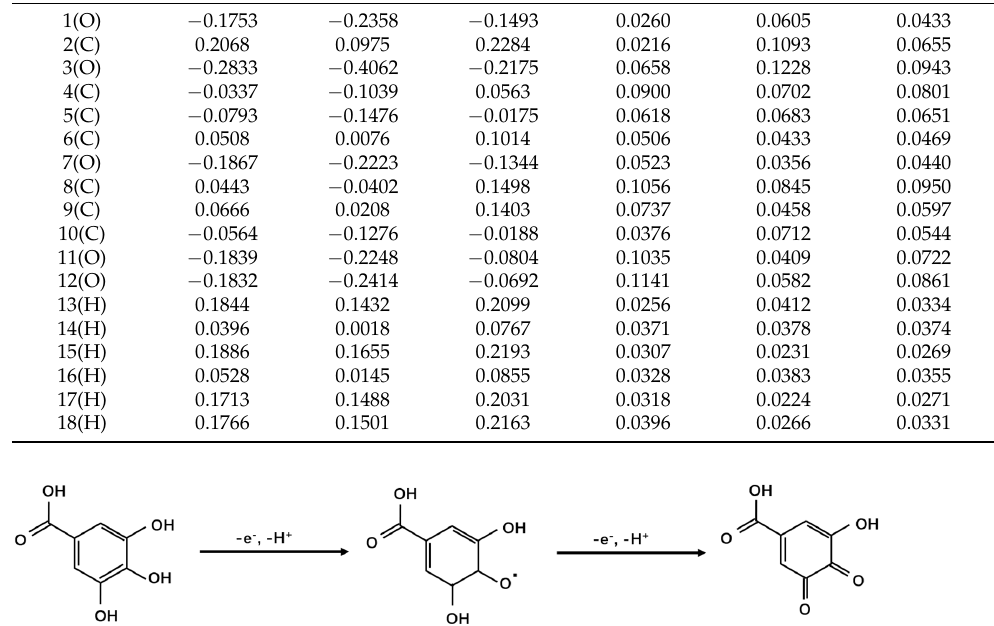
Figure 7. The possible electrochemical reaction mechanism of GA on modified electrode. Table 1. Bond order values of GA.